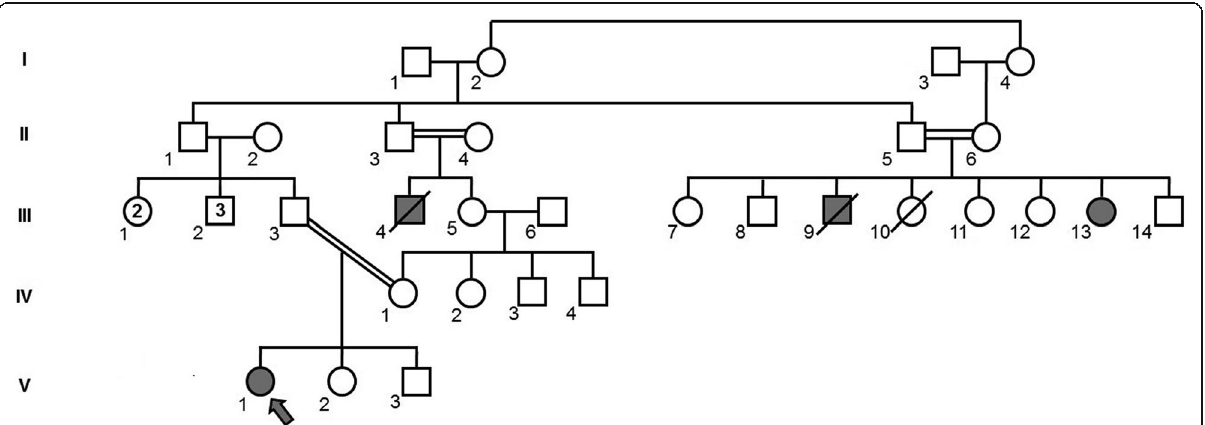
Fig. 2 Genogram of a multiply affected family with Progressive Pseudorheumatoid Dysplasia. Proband is denoted by the arrow. Full symbols designate affected individuals. Sequencing of the WISP3 gene revealed the affected individuals (V:1, III:13) to be homozygous